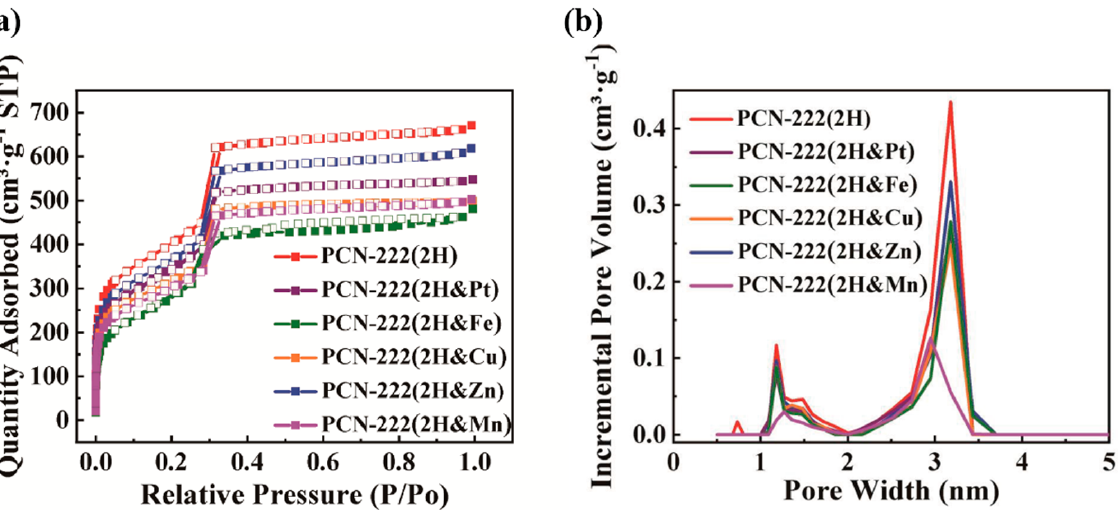
Figure 3. ( a ) Nitrogen adsorption/desorption isotherms of PCN-222 materials at 77 K (adsorption is marked by filled squares; desorption is marked by empty squares) and ( b ) pore size distribution of PCN-222(2H) and PCN − 222(2H&M).